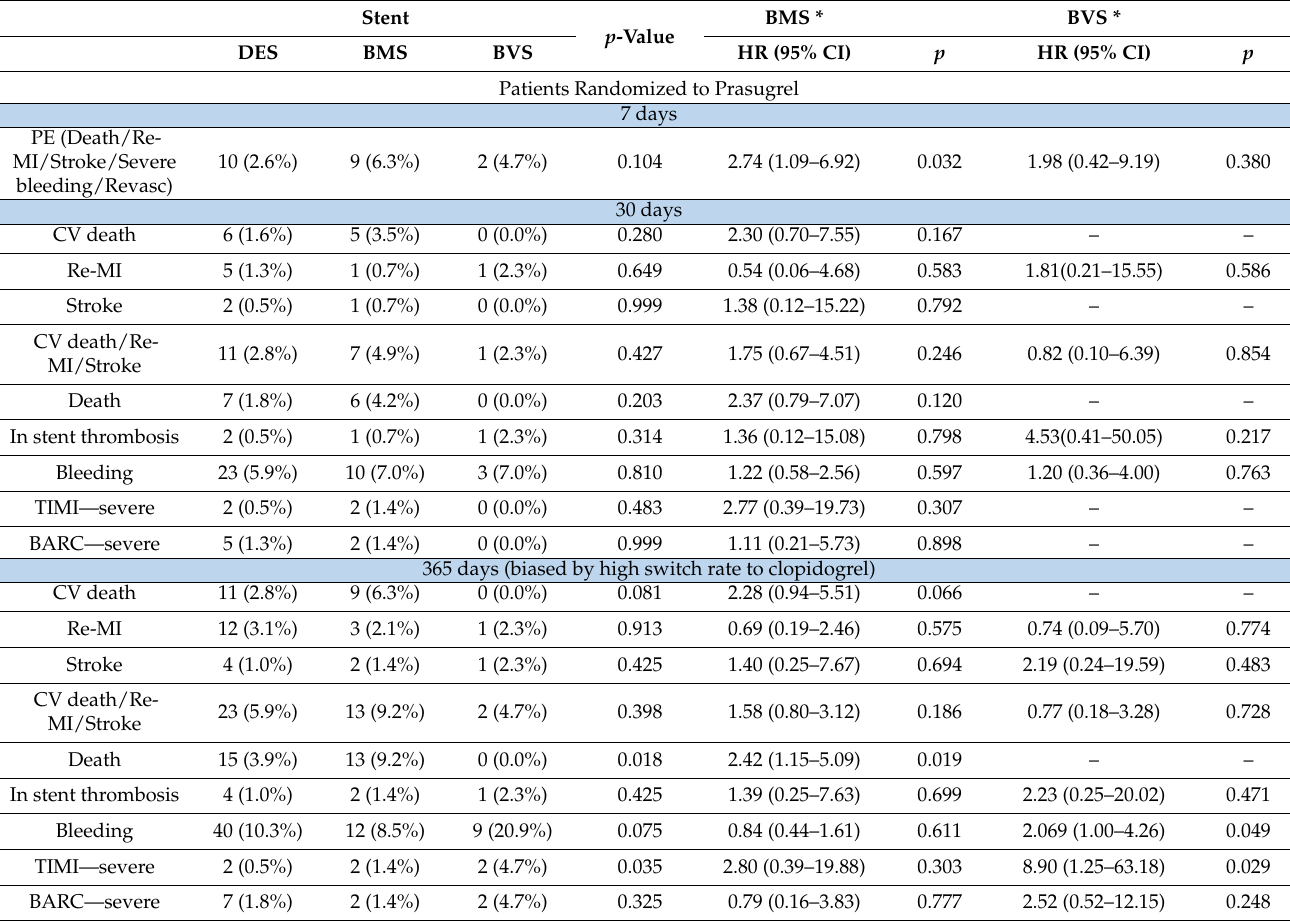
Table 3. Comparison of endpoint occurrence among patient groups by stent type (DES vs. BMS vs. BVS)—stratified according to study medication (prasugrel and